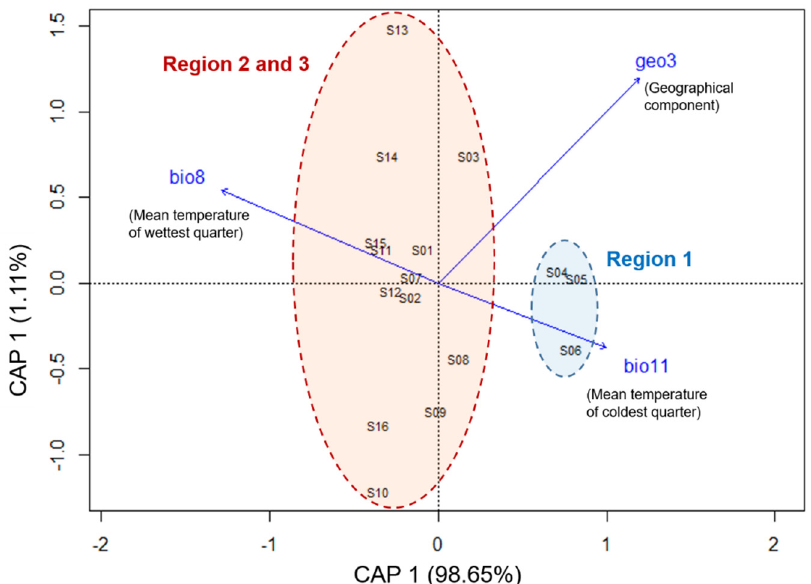
Figure 3. Plot of distance-based redundancy analyses from the final model. The dbRDA plot partitioned the genetic variance of Ae. albopictus populations explained by the predictor variables including two climatic variables, bio8—mean temperature of wettest quarter, bio11—mean temperature of coldest quarter and a spatial component, geo3—third-order polynomials transformation. Site codes are corresponded with definition in Table 1. Population clusters were indicated by colored circles, in which blue circle clustered populations from region 1 while red circle represent for group of populations from region 2 and 3. The first two axes explained 98.65% of the variability in the final model. Vector notations indicate the strength of the relationship between predictor variables and the dbRDA axes.